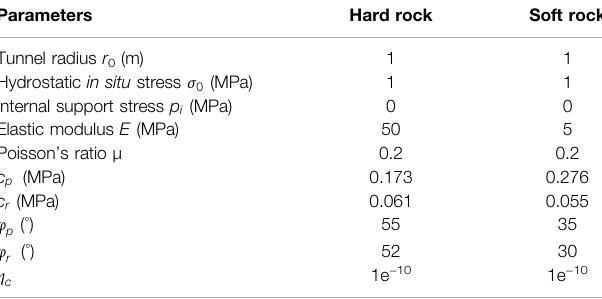
TABLE 1 | Basic parameters for the elastic – brittle – plastic rock mass (Zou, Li, and Wang 2017). Parameters Hard rock